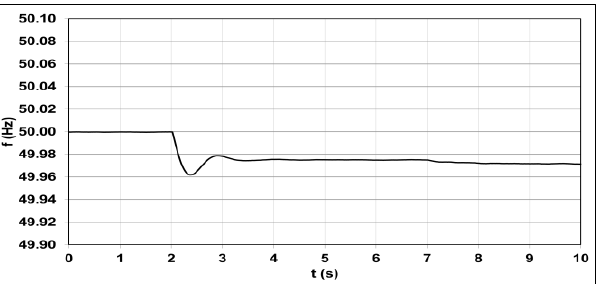
Figure 17. Frequency changes resulting from including the farm in voltage regulation.